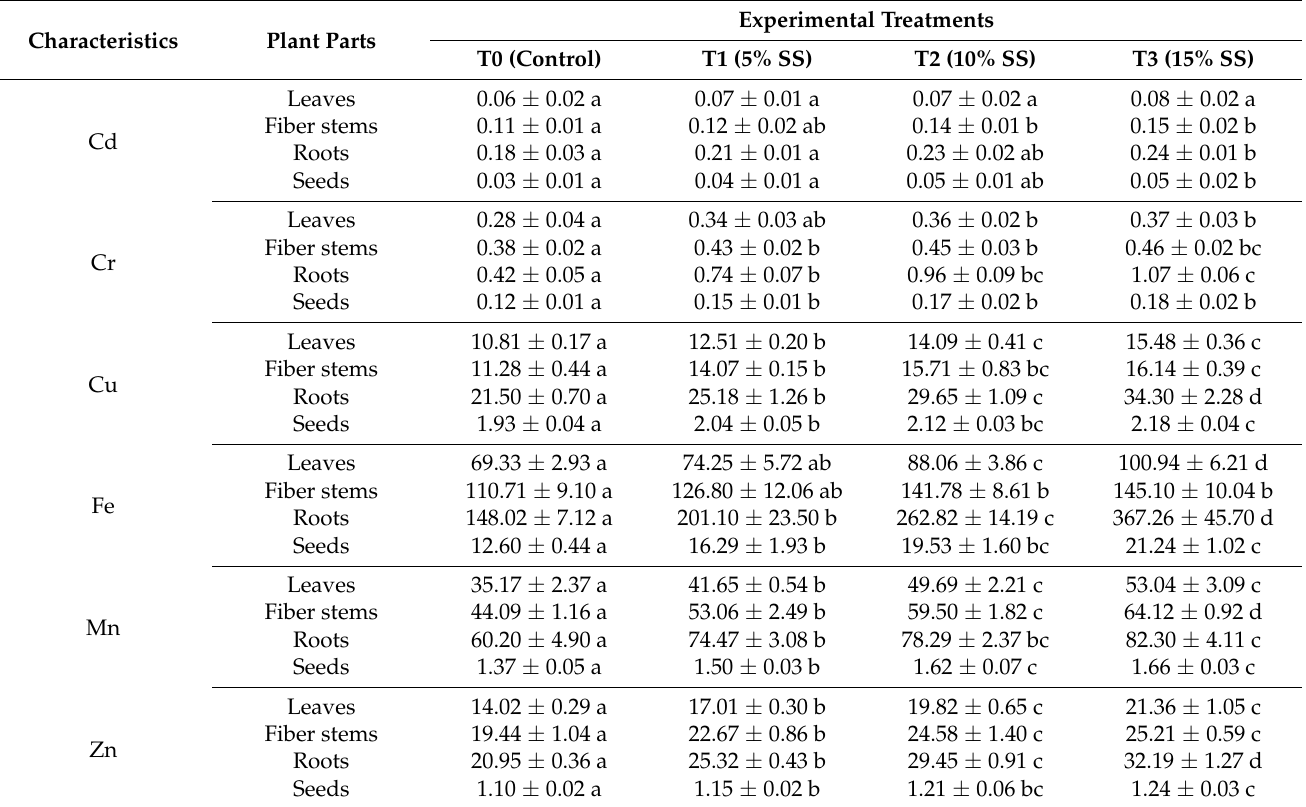
Table 3. Effects of different loading rates of sewage sludge on heavy metal concentrations (mg/kg) in different parts of cultivated dhaincha ( S. bispinosa